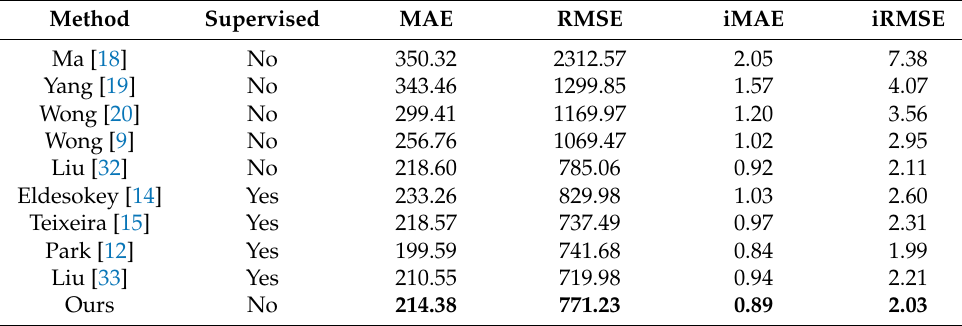
Table 2. Quantitative results of the KITTI test